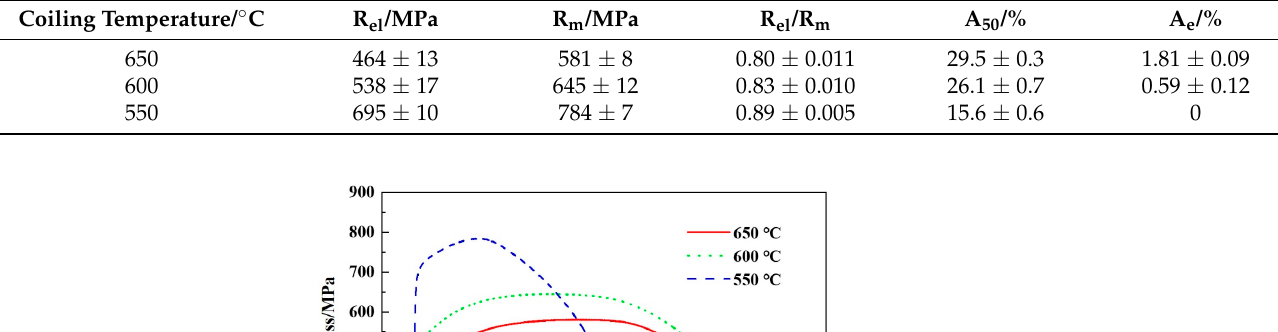
Table 2. The mechanical properties of test steel at different coiling temperatures.